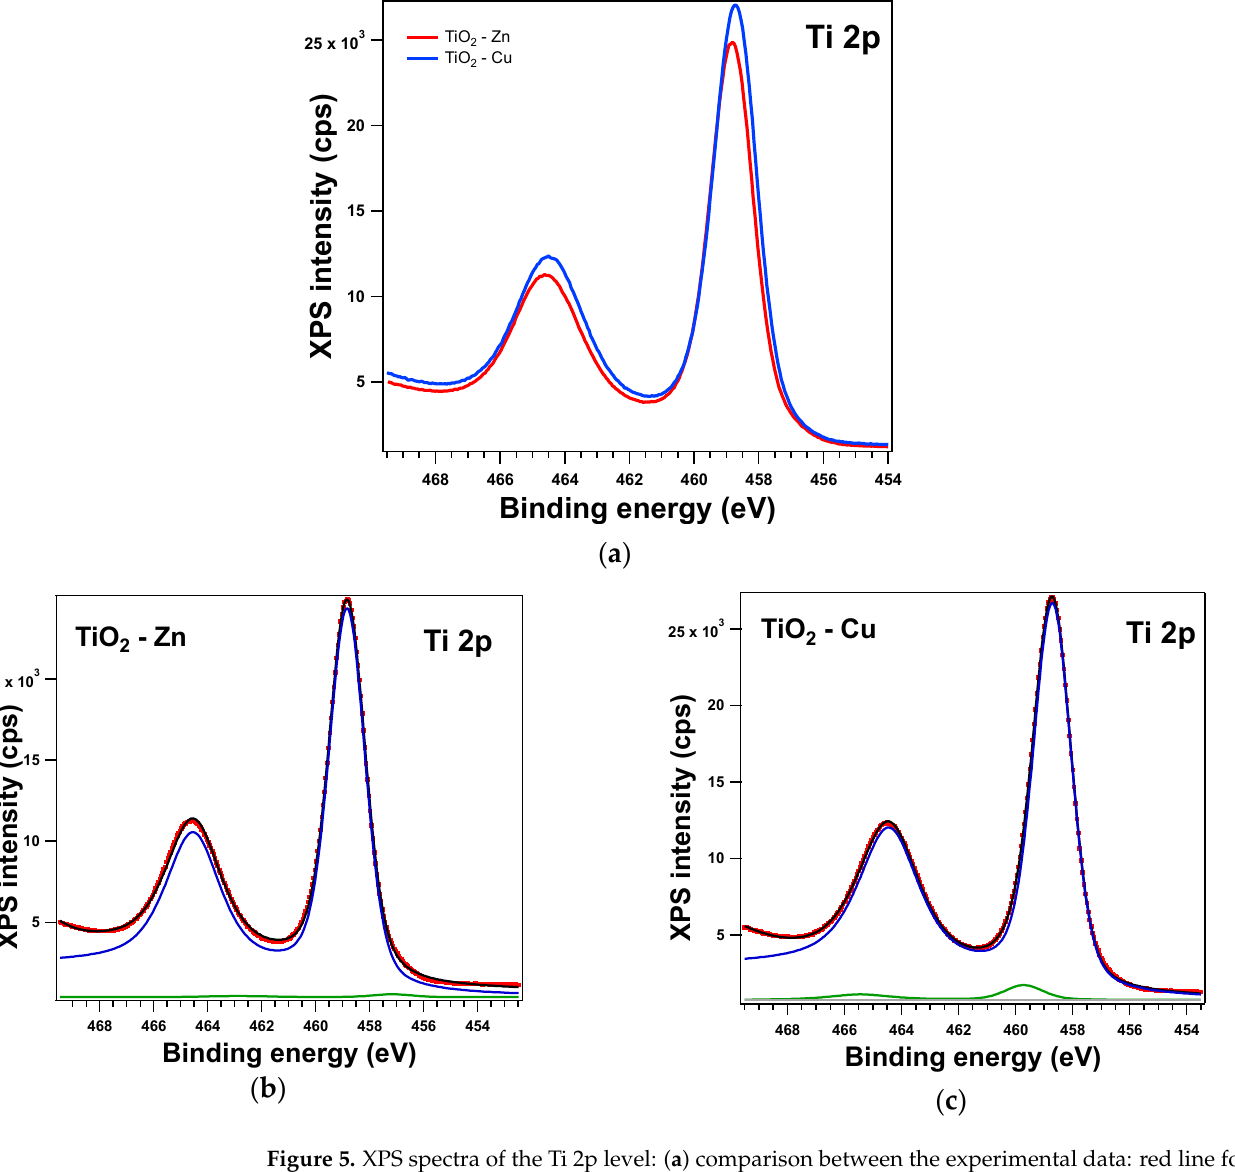
Figure 5. XPS spectra of the Ti 2p level: ( a ) comparison between the experimental data: red line for Zn-doped samples and blue line for the Cu-doped samples, and ( b , c ) the fit and deconvolutions for the Zn sample and Cu sample, respectively: red symbols for the experimental data overlayed with a black line for the fi t, blue line for C1, and green line for C2.